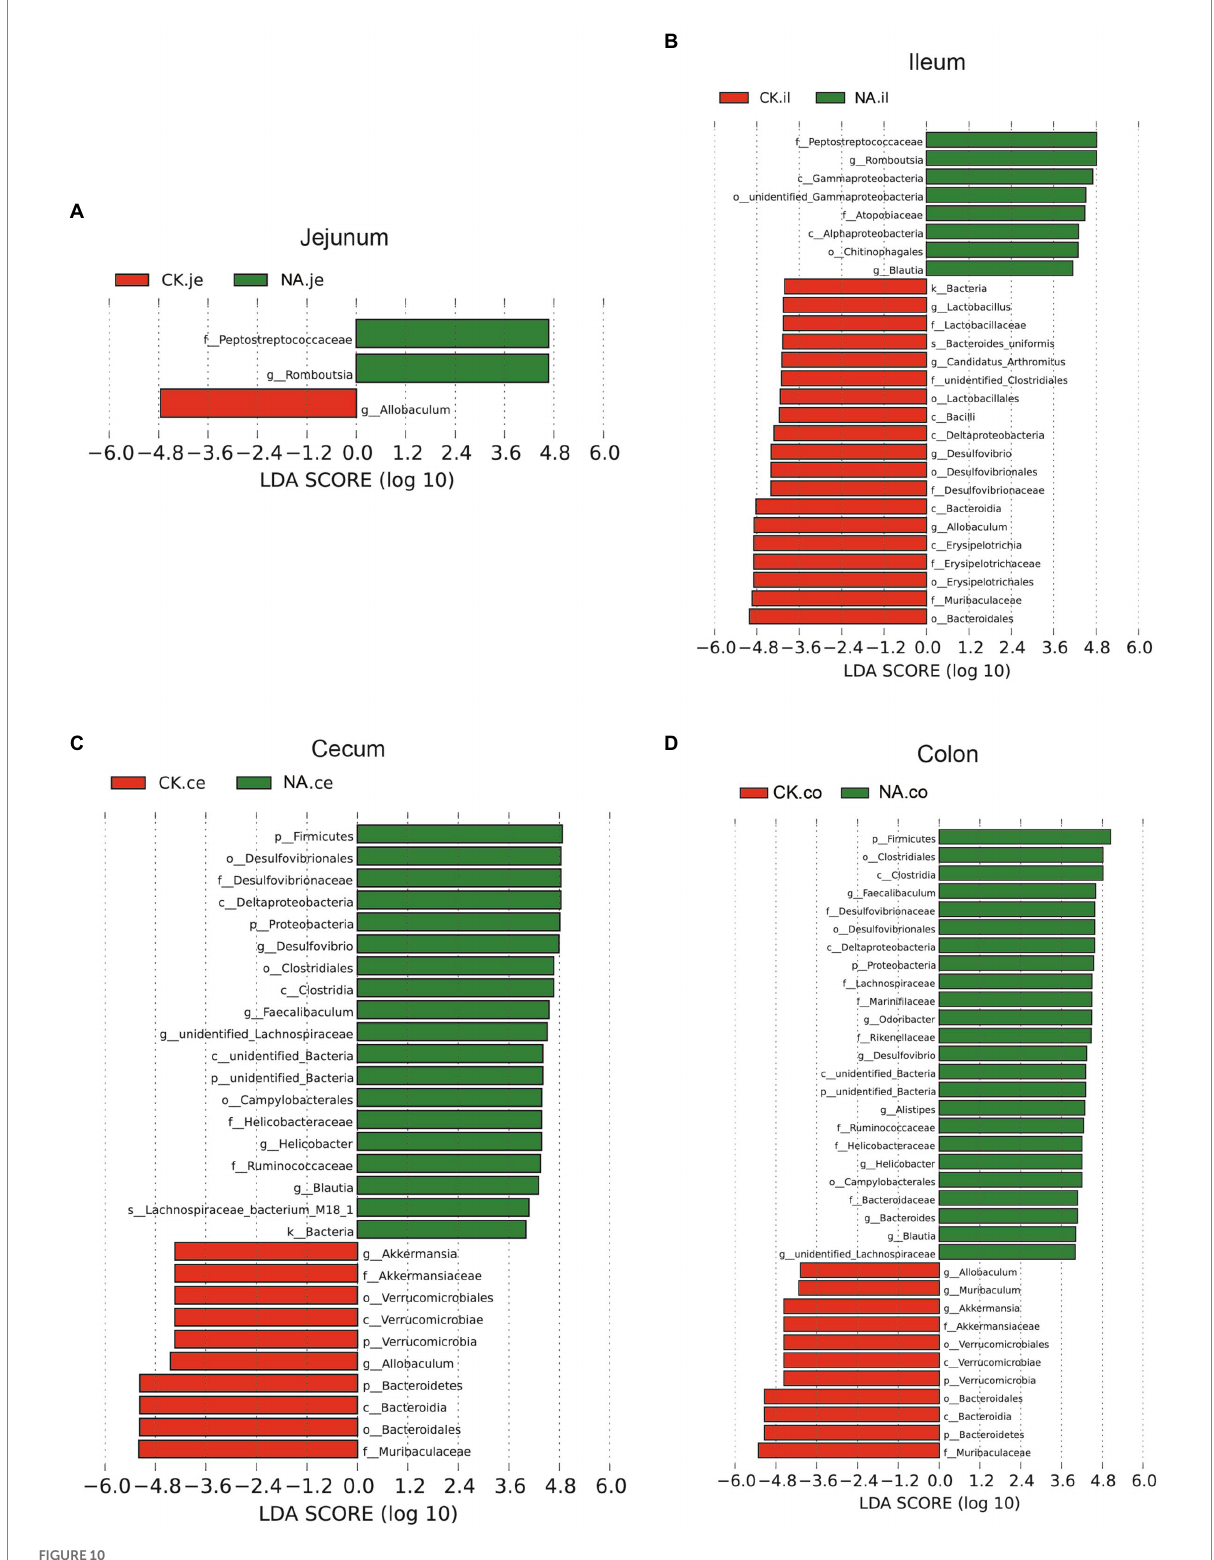
FIGURE 10 LEfSe analysis of intestinal microbiota in the same segment between CK group and NAFLD (NA) group. (A) Jejunum; (B) Ileum; (C) Cecum; (D) Colon ( α = 0.05, logarithmic Linear Discriminant Analysis (LDA) score threshold =